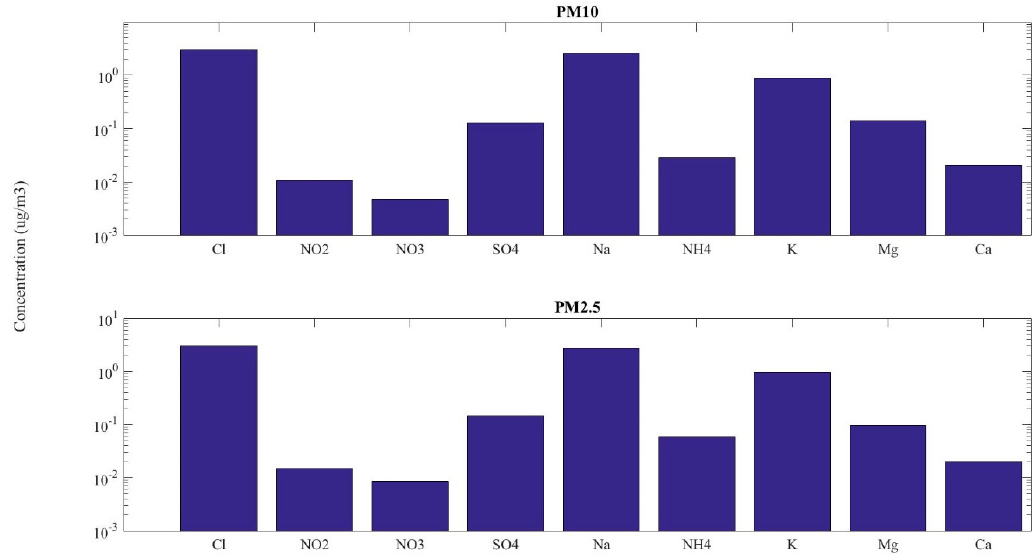
Figure 10. The results of the IC analysis, plotted on a log